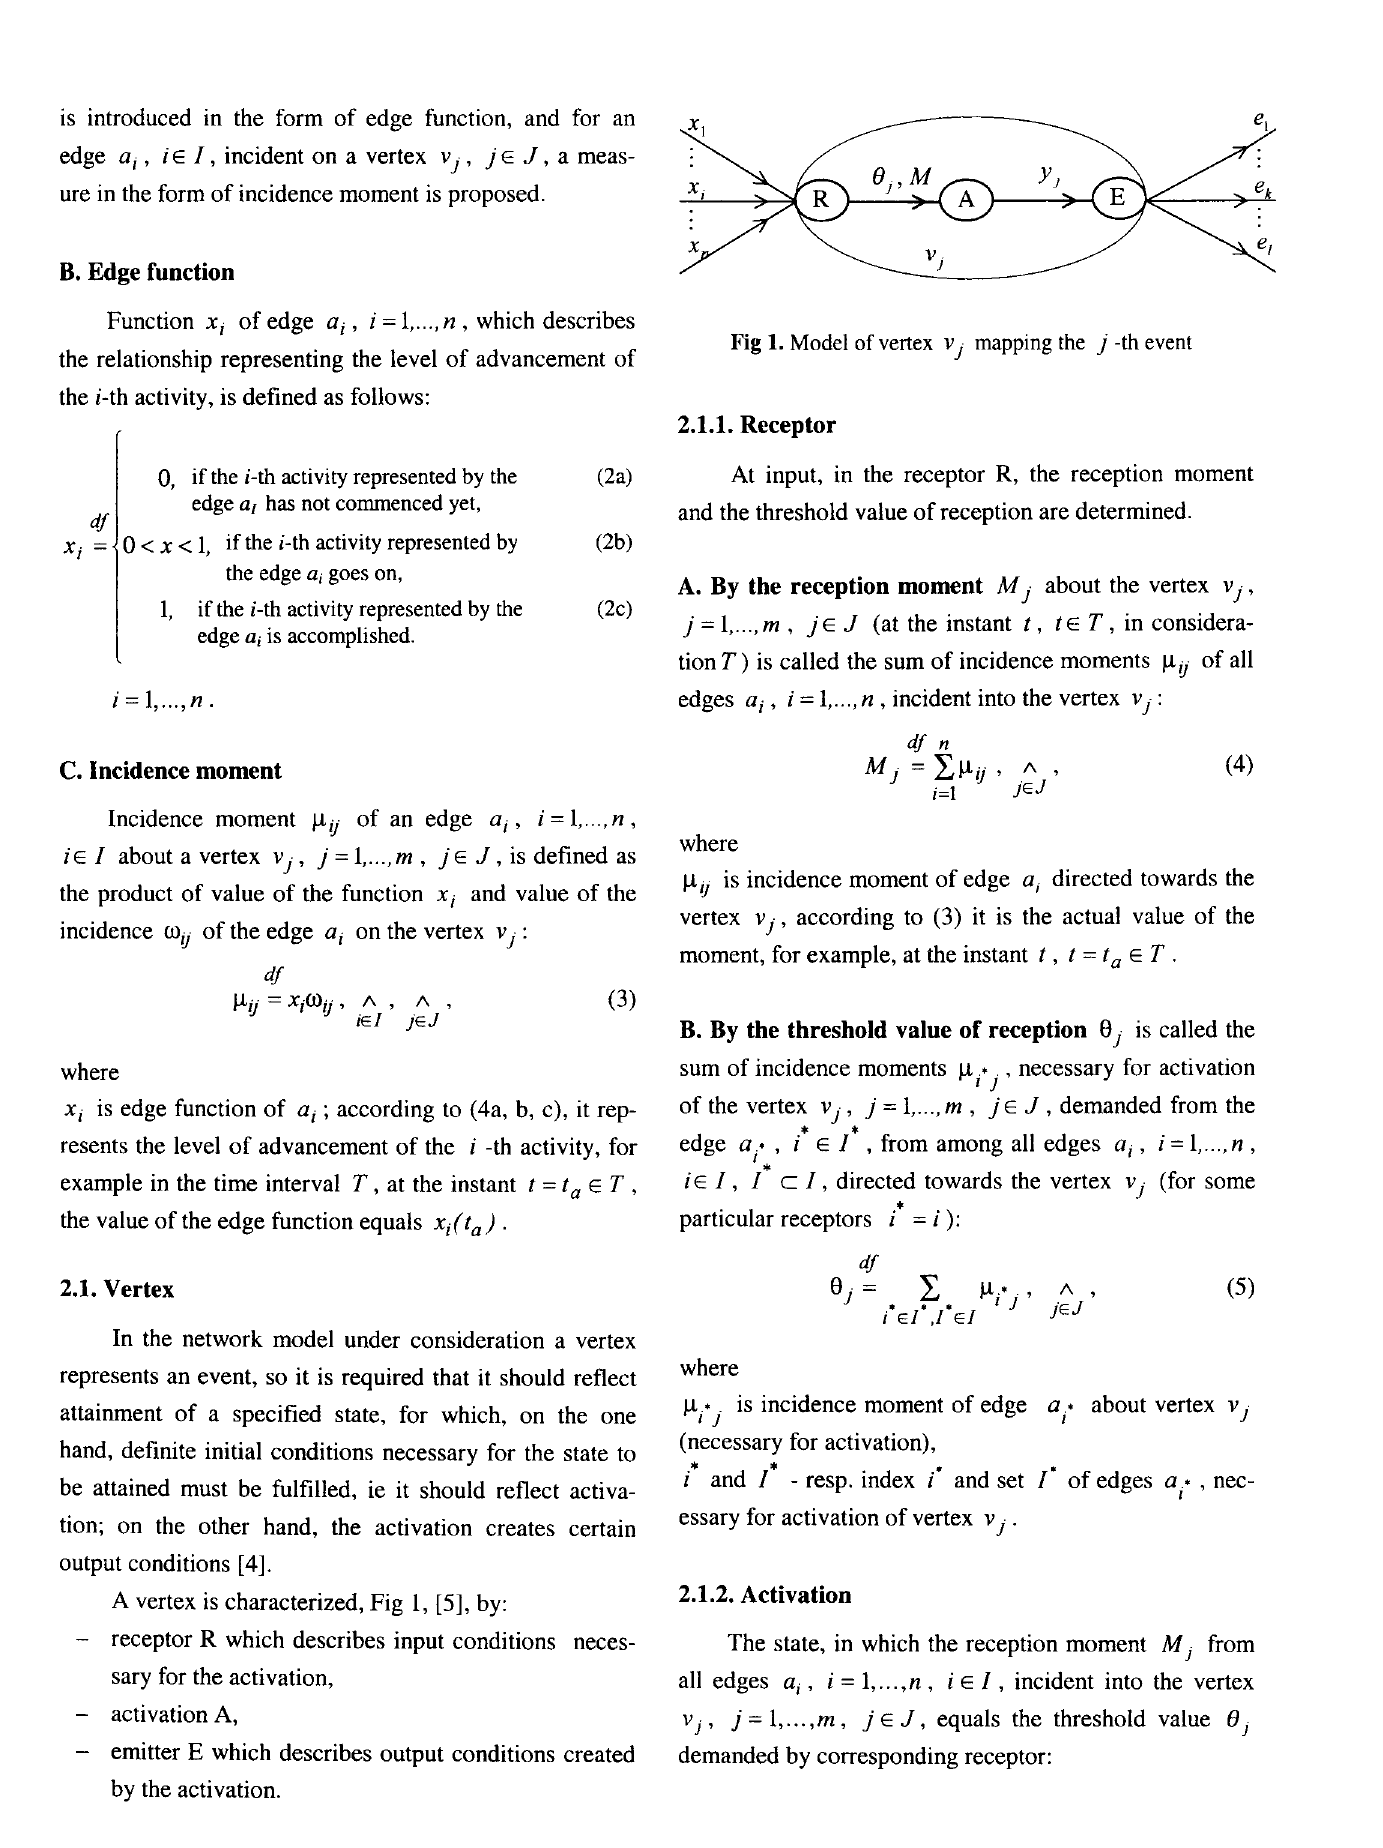
Fig 1. Model of vertex vi mapping the j -th